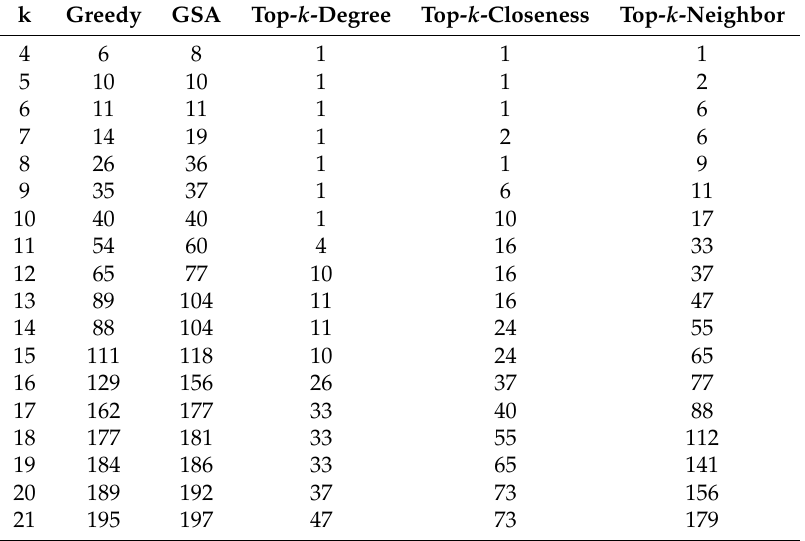
Table 10. The comparison of the approximate algorithm with the baseline algorithms: